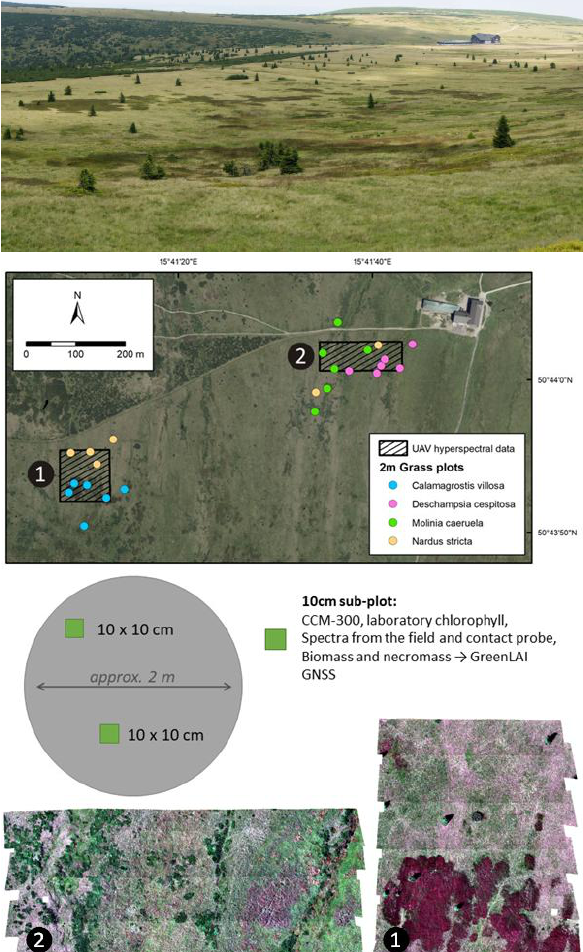
Figure 1. The study area of the grassy tundra around the Luční bouda chalet (up), the sampling design (in the middle) and the examples of Headwall Nano-Hyperspec® data acquired in August 2020 for both test areas